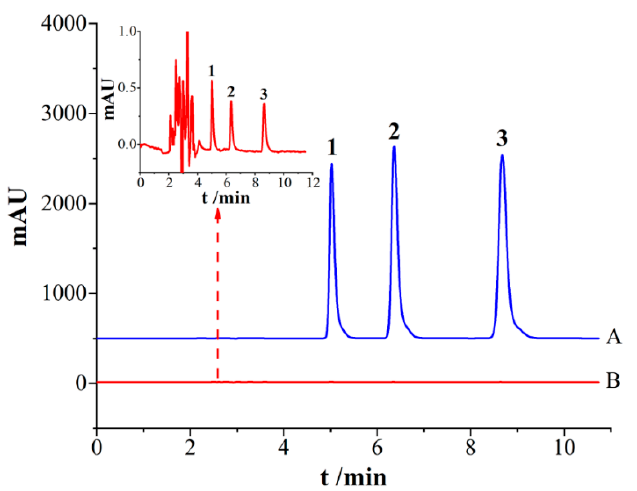
Figure 7. Chromatograms of PA commercial fiber array and SMIP fiber array for extraction PBs. A—SMIP fiber array; B—PA fiber array; 1. MP; 2. EP; 3.